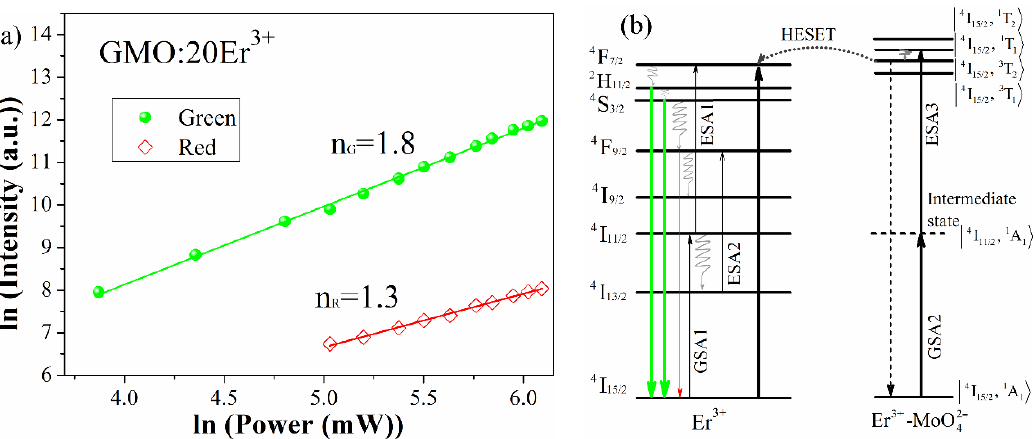
Figure 3. GRR as a function of Er 3+ concentration in Gd 2 (MoO 4 ) 3 : x Er 3+ phosphors ( a ). CIE chromatic ‐ ity diagram of Gd 2 (MoO 4 ) 3 :20Er 3+ phosphor ( b ).